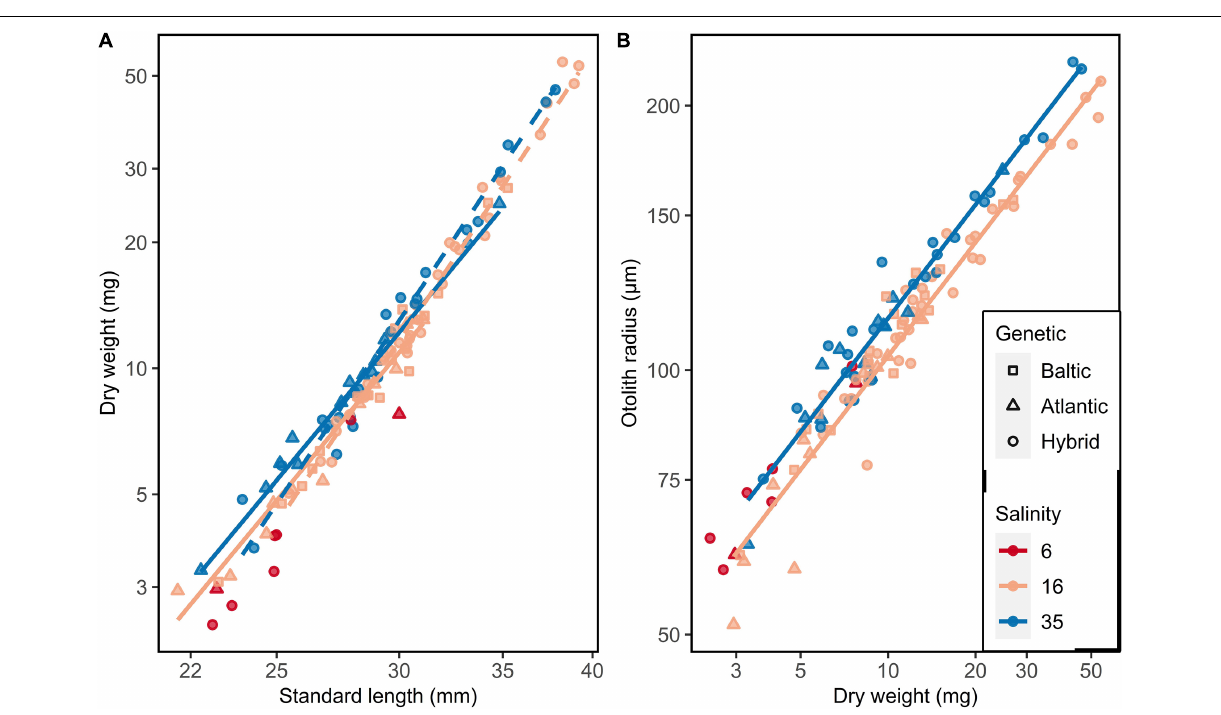
FIGURE 5 | Somatic growth of F1 larvae used for otolith microstructure analysis. (A) Length-weight relationship and (B) Dry weight-otolith radius. Lines represent linear models: (A) Solid line = Atlantic purebred, dashed line = Atlantic/Baltic hybrids; (B) no significant differences between genetic